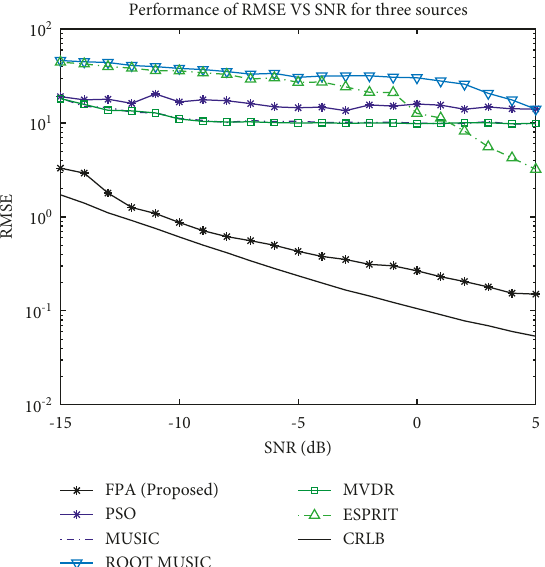
Figure 8: Performance of RMSE vs SNR for three sources.